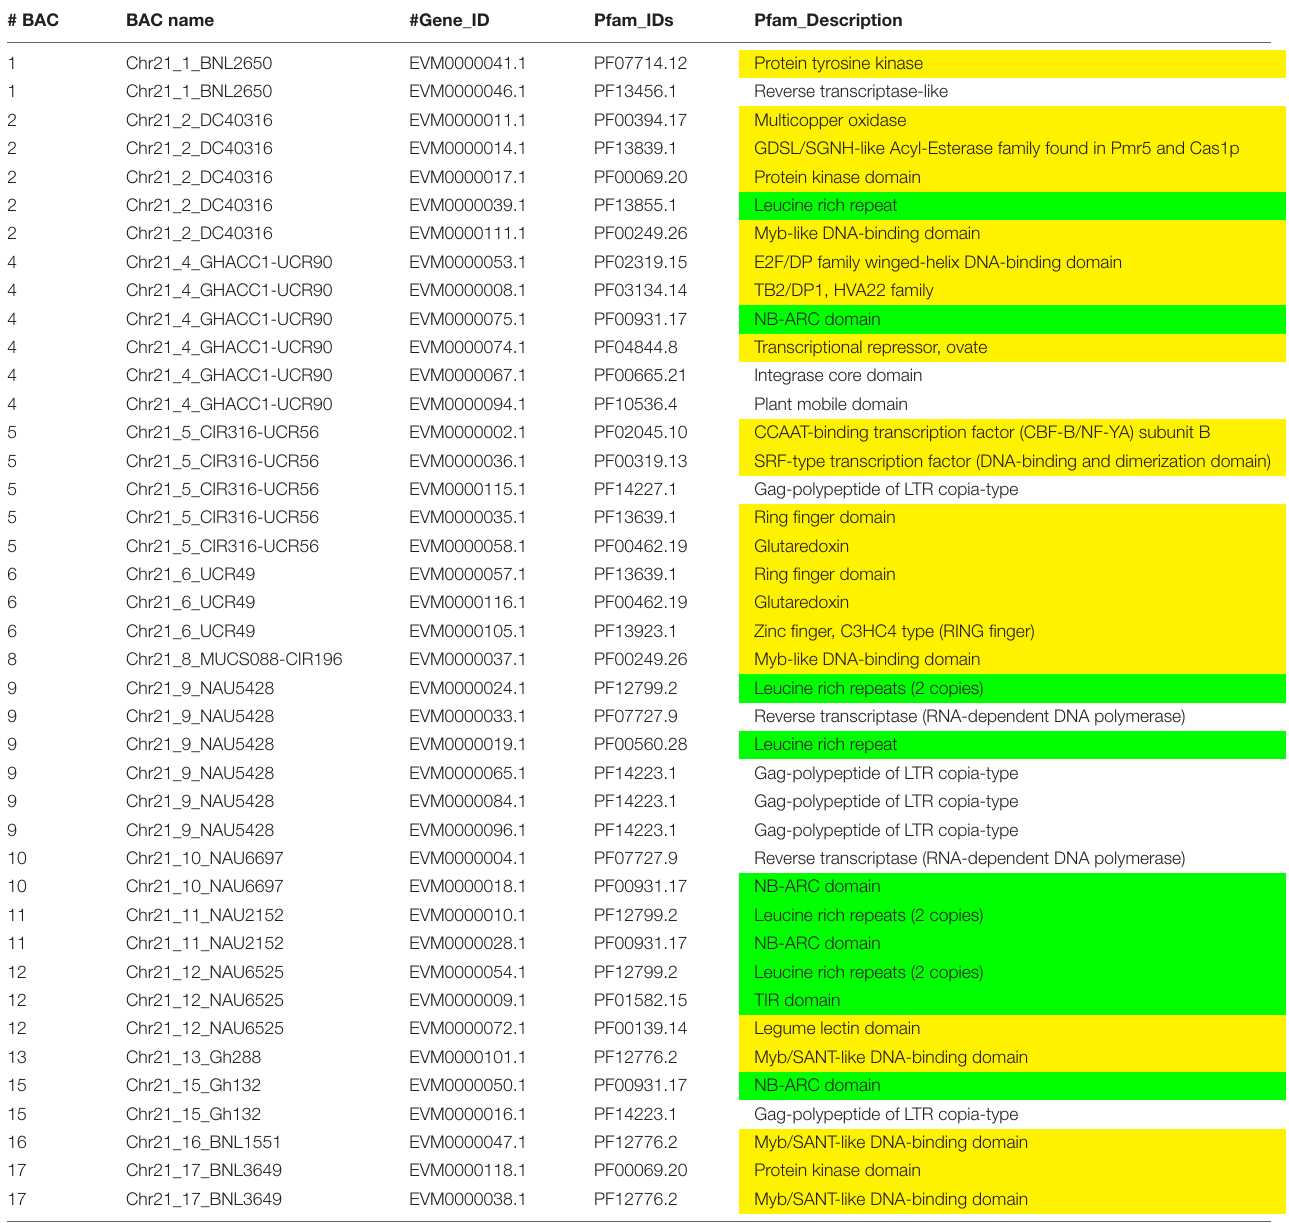
TABLE 4 | The Pfam (Protein family, http://pfam.xfam.org/) gene annotation of Chr 21 BACs with a similar e value cutoff ≤